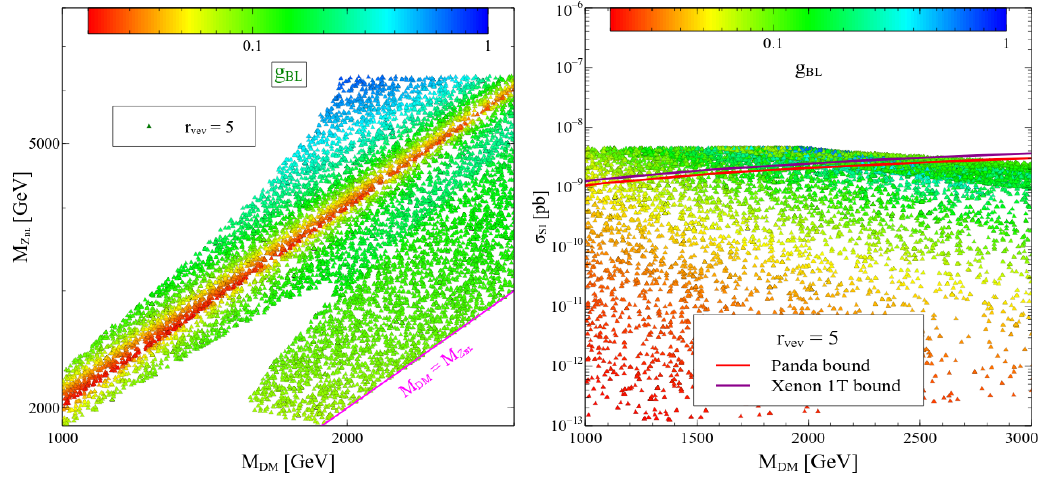
Figure 10 . Left (right) panel: scatter plot in the M DM the DM relic density bound. The parameters range have been shown in the table 2 and other parameters have been kept (cid:12)xed at r vev = 5, M N